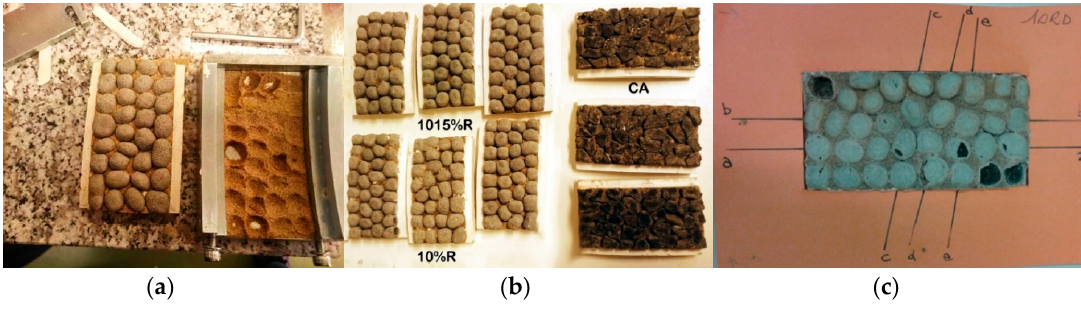
Figure 10. Specimens preparation for polishing test: ( a ) specimen demoulding; ( b ) sets of the experimentation specimens before polishing; ( c ) an example of superficial fragmentation of some granules after polishing test for a 10%R sample.